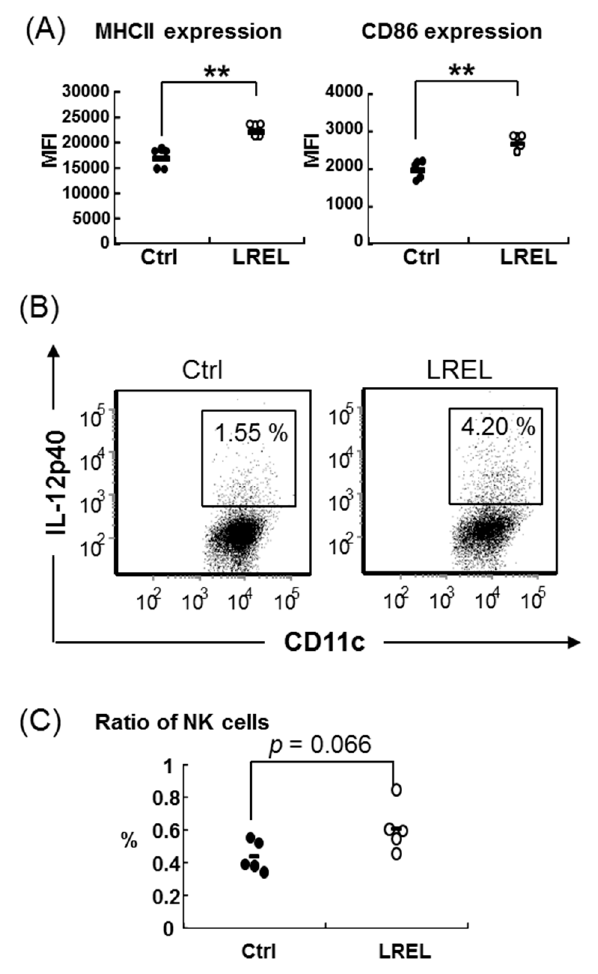
Figure 3. Mucosal DCs activation and NK cells increase by LREL single dose oral treatment. Healthy C57BL/6J mice were divided into control and LREL groups ( n = 5 in each group); mice in the LREL group received oral administration of 10 mg LREL dissolved in PBS and mice in the control group received oral administration of the same volume of PBS. After 24 h, all mice were sacrificed and the activities of mDCs (gated on CD11c + CD11b + CD8 α − PDCA-1 − ) and NK cells (gated on NK1.1+ CD3 ε − ) in MLN were analyzed by flow cytometry. ( A ) Comparison of cell surface activation marker expression on MLN mDCs between the control and LREL group. Expression levels of MHC class II (left panel) and CD86 (right panel) were analyzed by flow cytometry (expressed as MFI). The short line represents the mean value ( n = 5). MLN mDCs were significantly activated by LREL oral treatment. ( B ) Representative ratio of IL-12p40 producing mDCs from the control and LREL group. Low density cells of MLN in the same group were pooled and analyzed by FACS. ( C ) Comparison of the ratio of NK cells in MLN. The ratio of NK cells was moderately increased in LREL group. ** p < 0.01 compared to control (Student’s t test).